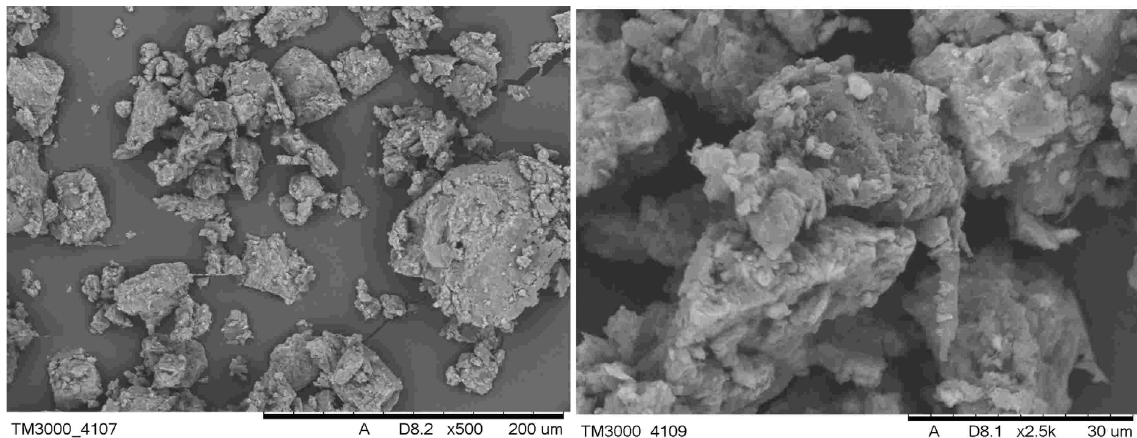
Figure 1: Sediment obtained after wastewater treatment with dose 3.0 mL PIX 113 per 1 L.